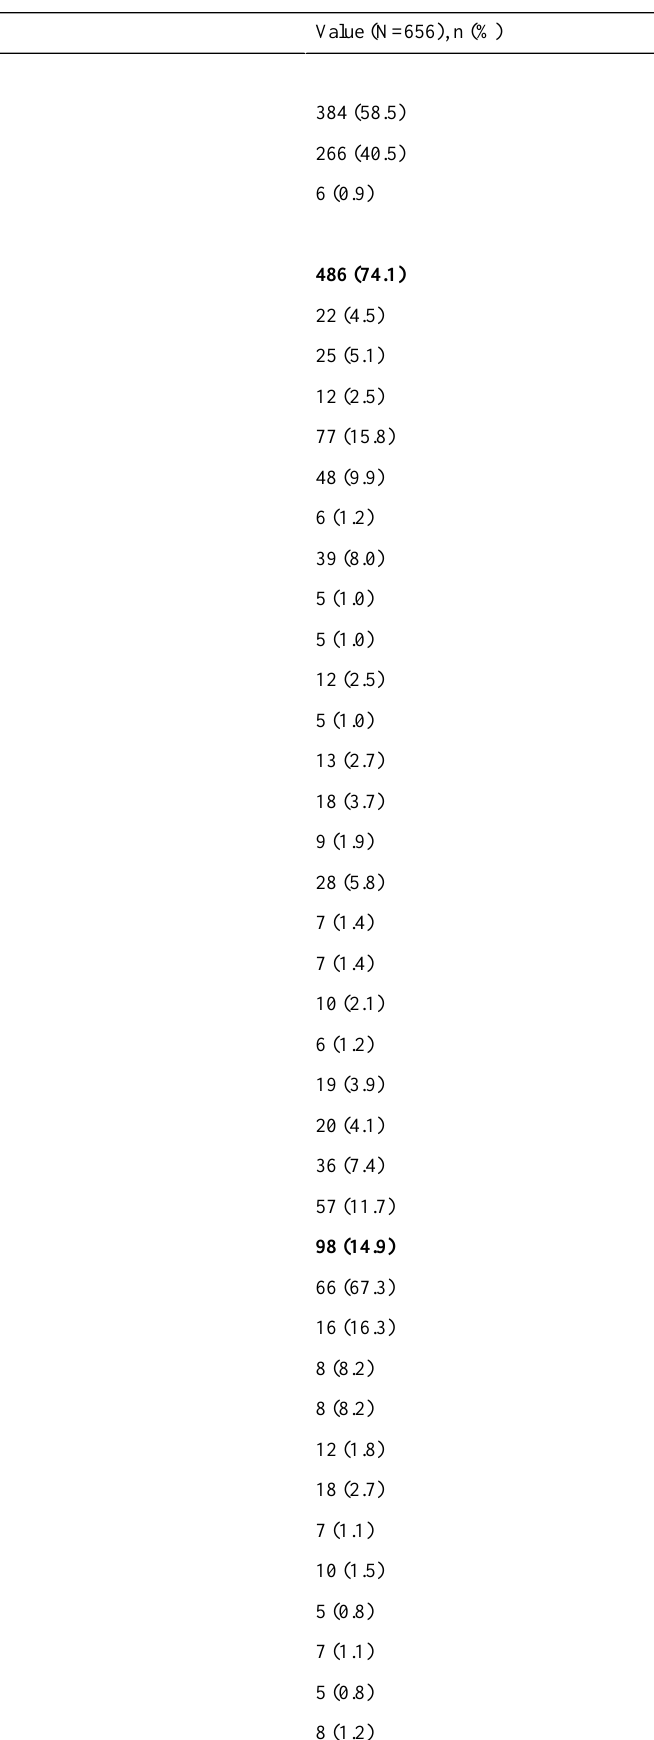
Table 1. Characteristics of doctors and health care professionals sharing tweets disclosing information about